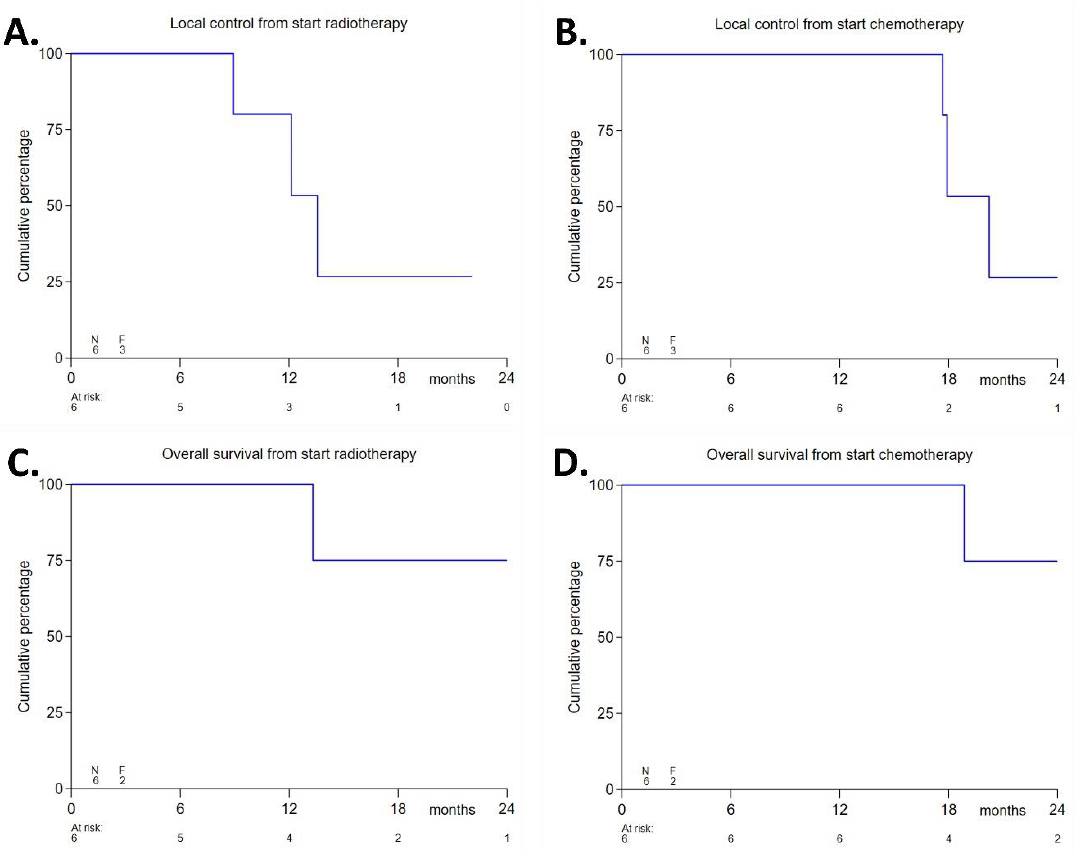
Figure 2. Efficacy endpoints: Local control from the start of radiotherapy ( A ), local control from the start of chemotherapy ( B ), overall survival from the start of radiotherapy ( C ), and overall survival from the start of chemotherapy ( D ). Table 7. Patient overview.